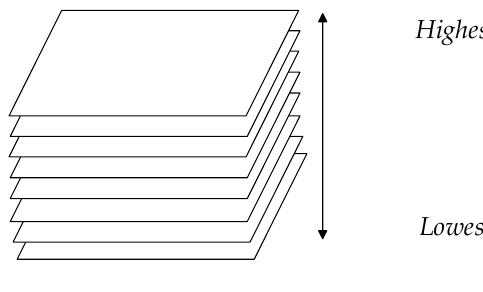
Figure 7. Bit plane stratification.